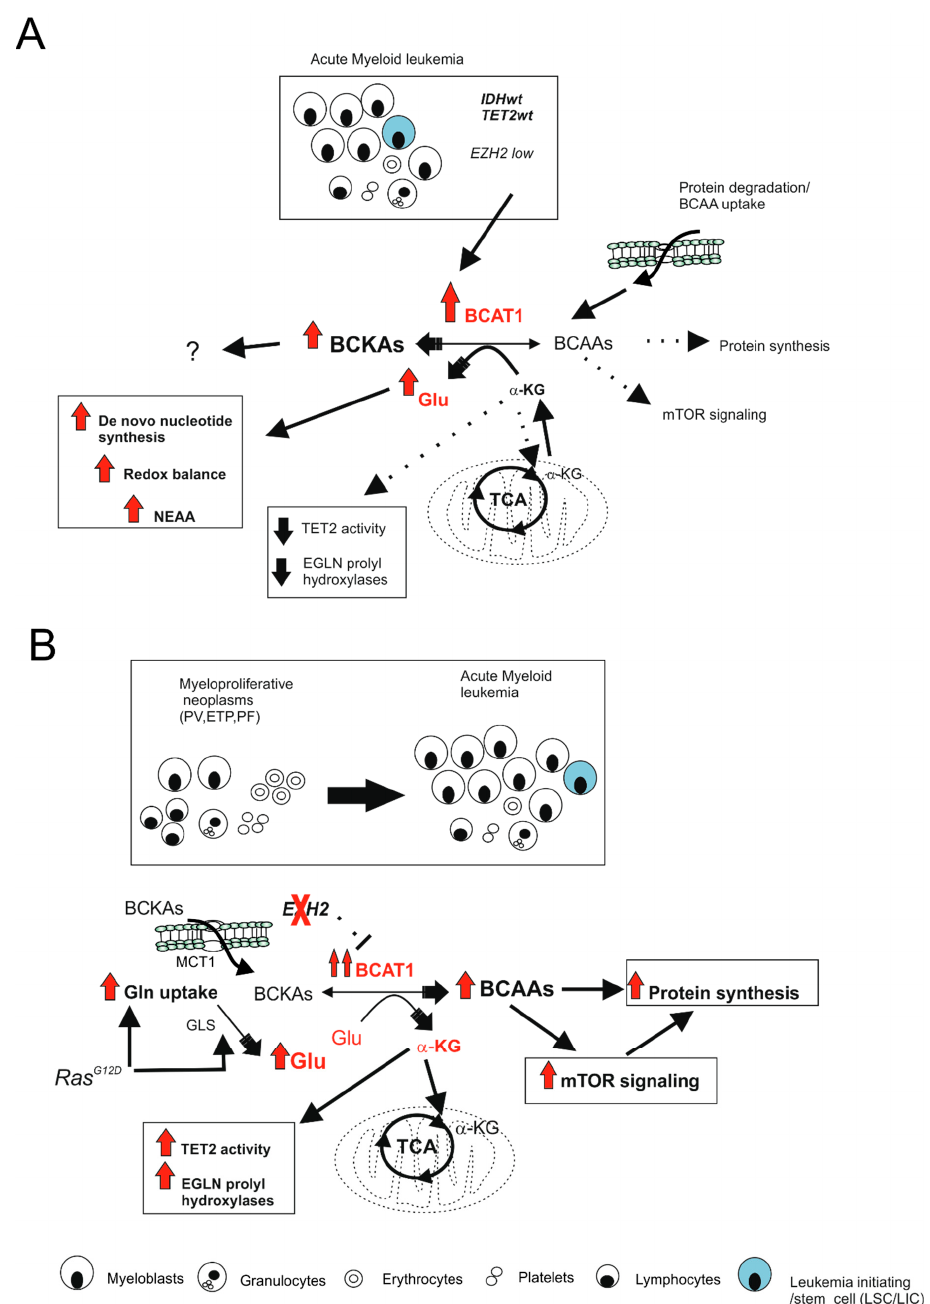
Figure 2. Oncogenic functions of BCAT1 are highly dependent on mutational and cellular context. ( A ) In AML, LICs showing high expression of BCAT1 but low levels of EZH2 (IDH1/2wt, TET2wt, EZH2wt genotype), BCAT1 catalyzes BCAA deamination with depletion of α -KG. This leads to a reduced activity of α -KG-dependent histone and DNA demethylases and α -KG-dependent dioxygenases with DNA hypermethylation and stabilization of HIF-1 α ; ( B ) In the transition from myeloproliferative diseases (MPN; PV, ETP, PF) to acute leukemia, EZH2 loss reactivates BCAT1 expression, while oncogenic RAS (NrasG12D) increases glutamine (Gln) uptake and consumption. This leads to enhanced BCAT1-catalyzed BCKA reamination to BCAAs and subsequent mTORC1 activation. The activity of α -KG-dependent enzymes is also enhanced as well as Glu-dependent processes such as nucleotide synthesis, redox balance, and protein synthesis. All these events contribute to myeloid transformation. Solid arrows indicate the activity of the pathway, dashed lines indicate inhibited or weak activities. GLS: glutaminase; Gln: glutamine; Glu: glutamate; BCAAs: branched chain amino acids; BCKA: branched chain α -keto acids; α -KG: apha-ketoglutarate; TET2: Ten-eleven translocation 2 demethylase; mTOR: Mammalian target of rapamycin; NEAA: non-essential amino acids; LICs: leukemia-initiating cells; PV: polycythemia vera; ETP: essential thrombocytopenia; PF: primary